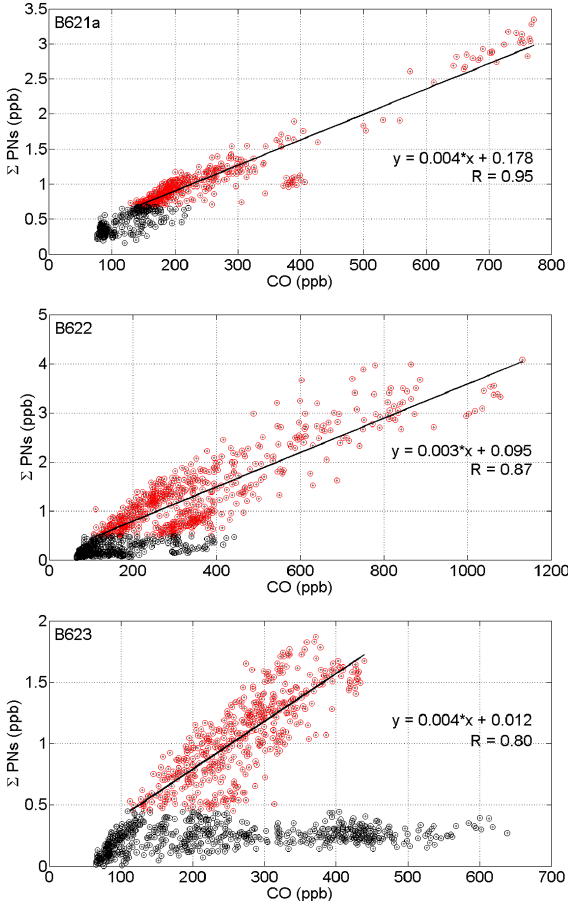
Figure 2. Scatter plot of the P PNs and the CO for the B621a, B622 and B623 flights (from the top to the bottom, respectively). The red circles indicate the data selected as BB plume using the 6 σ method to the P PN measurements; the black circles indicate the background air masses.